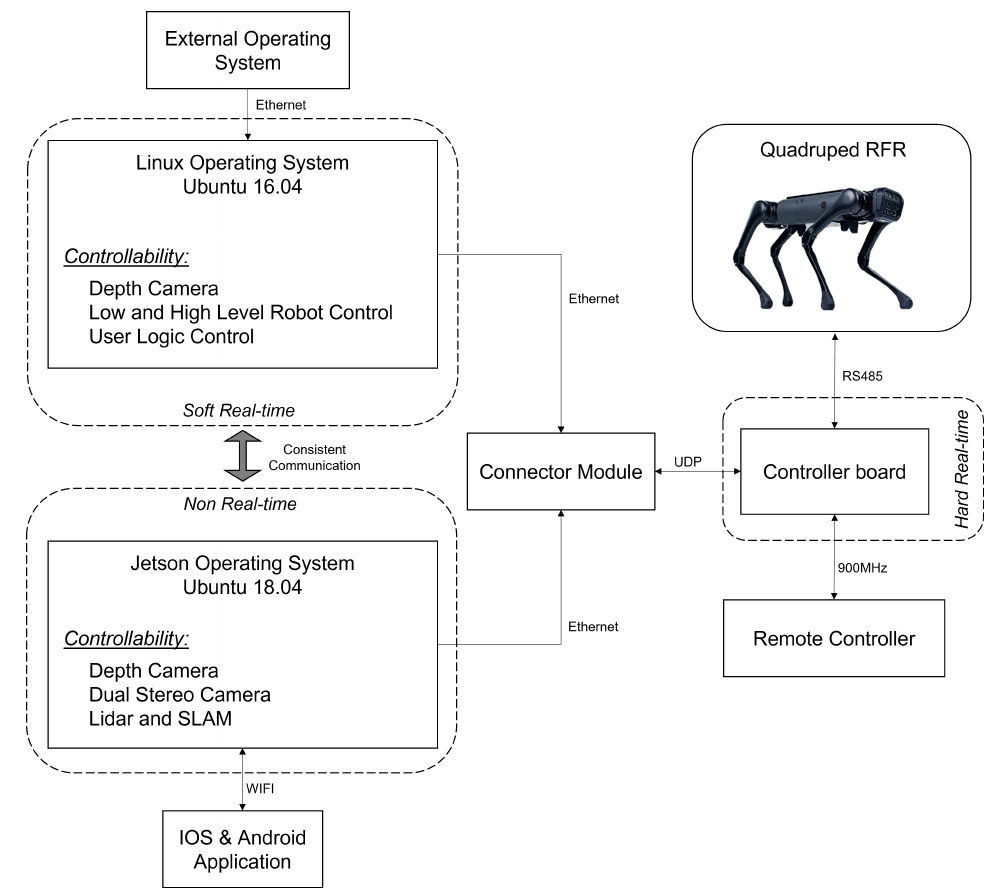
Figure 4. Full system architecture of the Aliengo